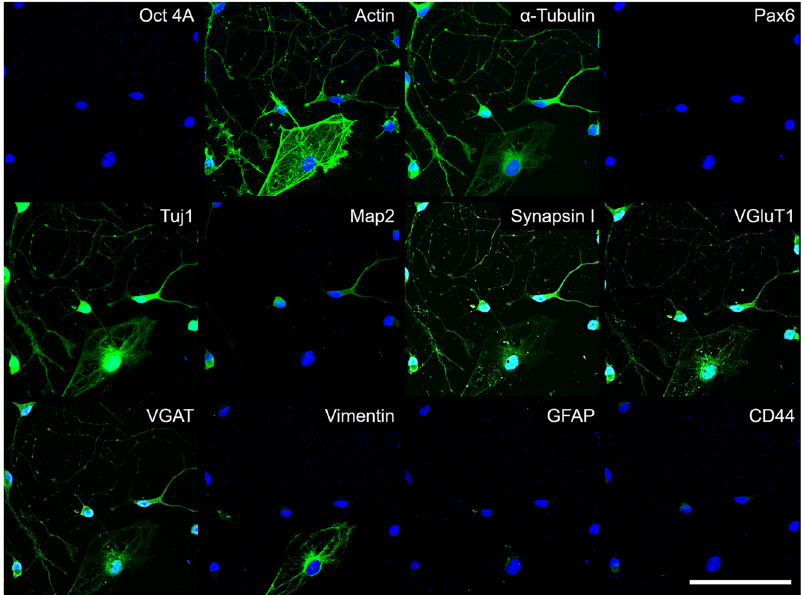
Fig. 4 High-content IF/ICC analysis of dissociated cultures from hiPSC-derived motor neuron culture. Representative images from the same area of a 1016A-derived motor neuron culture, stained with the optimized 12-marker PRISM antibody panel after being grown for 21 days as a 3D spheroid, then dissociated into 2D and maintained for 14 days. Scale bar is 100